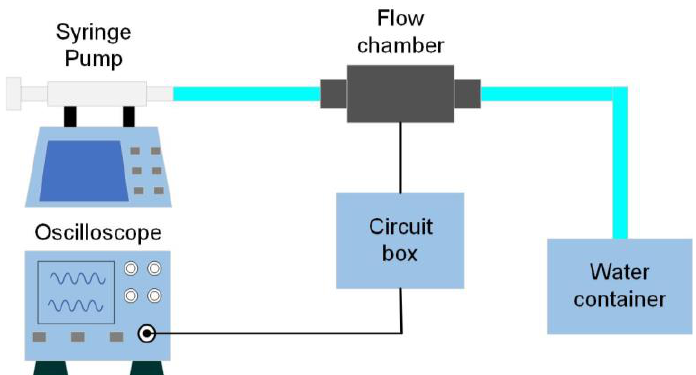
Figure 9. Schematic of the experimental setup for characterization of the volumetric flow sensor.